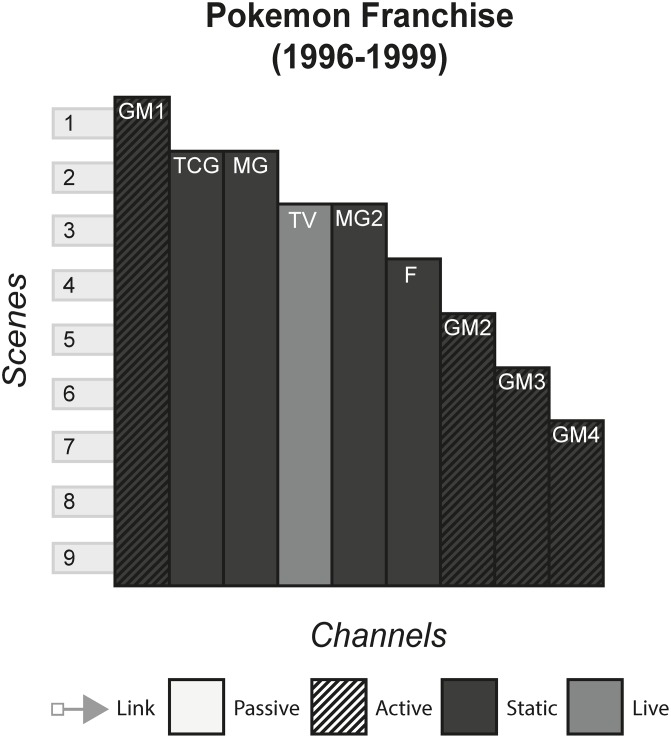
Pokémon franchise.